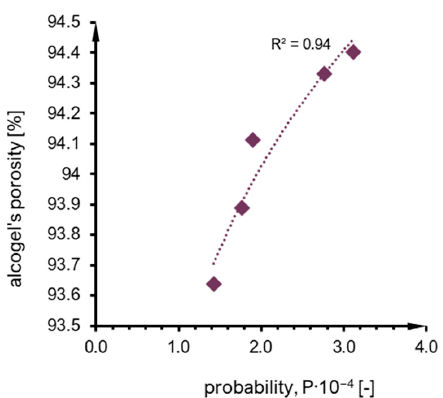
Figure 15. An alcogel’s porosity due to probability value—results for experimental syntheses.